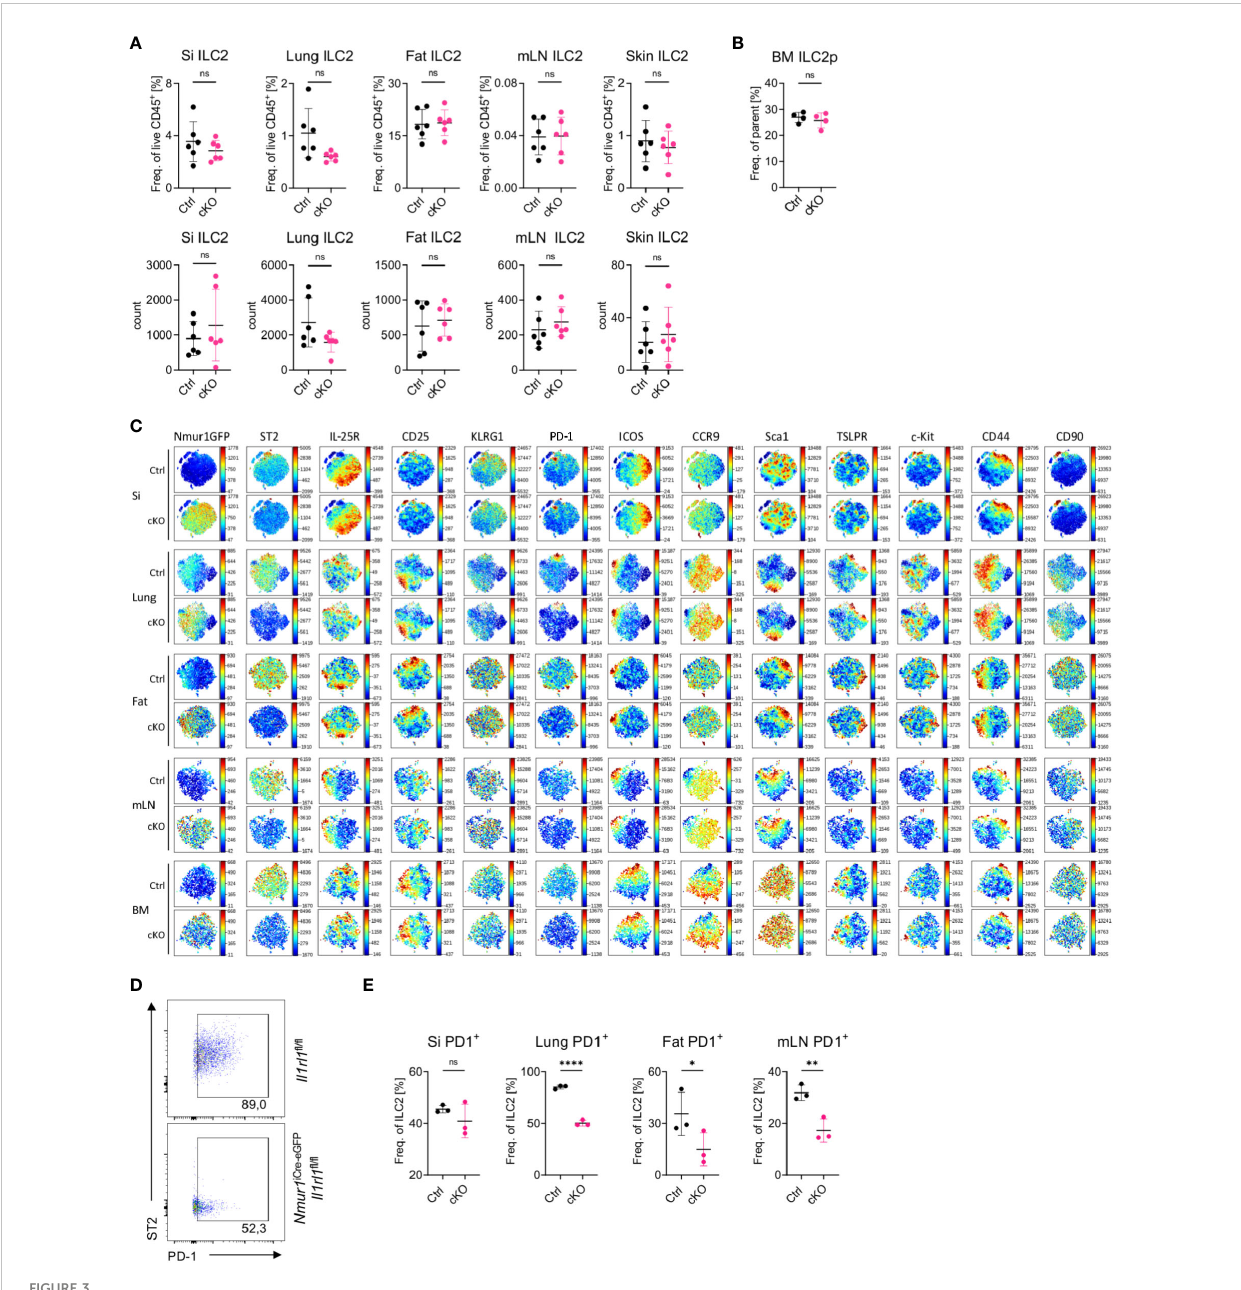
FIGURE 3 ILC2 develop in normal proportions without ST2 but have reduced PD-1 expression (A) , Quanti fi cation of relative and absolute ILC2 numbers in Il1rl1 fl ox/ fl ox (Ctrl) and Nmur1 iCre-eGFP Il1rl1 fl ox/ fl ox (cKO) mice across different organs in steady state. (B) , Quanti fi cation of relative ILC2 progenitor numbers in Il1rl1 fl ox/ fl ox (Ctrl) and Nmur1 iCre-eGFP Il1rl1 fl ox/ fl ox (cKO) mice in the BM. (C) , t-distributed stochastic neighbour embedding plots showing the expression level of different ILC2 markers. ILC2s from naïve Il1rl1 fl ox/ fl ox (Ctrl) and Nmur1 iCre-eGFP Il1rl1 fl ox/ fl ox (cKO) mice are shown. Each dot represents a single cell. Data are representative of two experiments with four to fi ve mice per group. (D) , Flow cytometric plots of PD-1 expression in lung ILC2s from Nmur1 iCre-eGFP Il1rl1 fl ox/ fl ox and Il1rl1 fl ox/ fl ox . (E) , Quanti fi cation of PD-1 expression in Il1rl1 fl ox/ fl ox (Ctrl) and Nmur1 iCre-eGFP Il1rl1 fl ox/ fl ox (cKO) mice across different organs in steady state. For (A, B, D) : Each symbol represents data from one mouse, data are representative of two experiments with three to eight mice per group. Mean +/- SD, student ’ s t-Test. ns not signi fi cant, *p < 0.05, **p < 0.01, ****p <